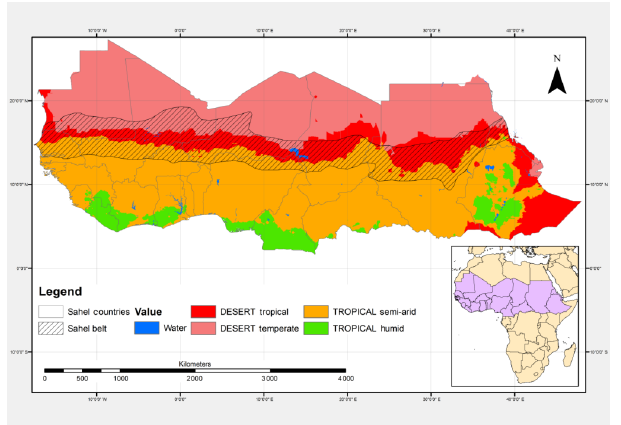
Figure 2. Major biome map from the year 2000 for the greater Sa- hel region. The hatched area shows the traditionally defined Sahel, where annual rainfall ranges from 100 to 600mm. The major biome map is based on Reich and Eswaran